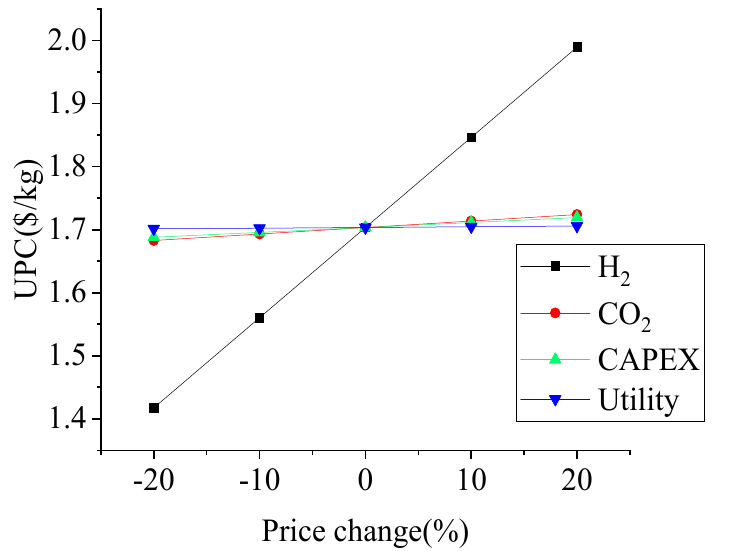
Figure 5. Sensitivity analysis of selected parameters for the Fischer–Tropsch process model.